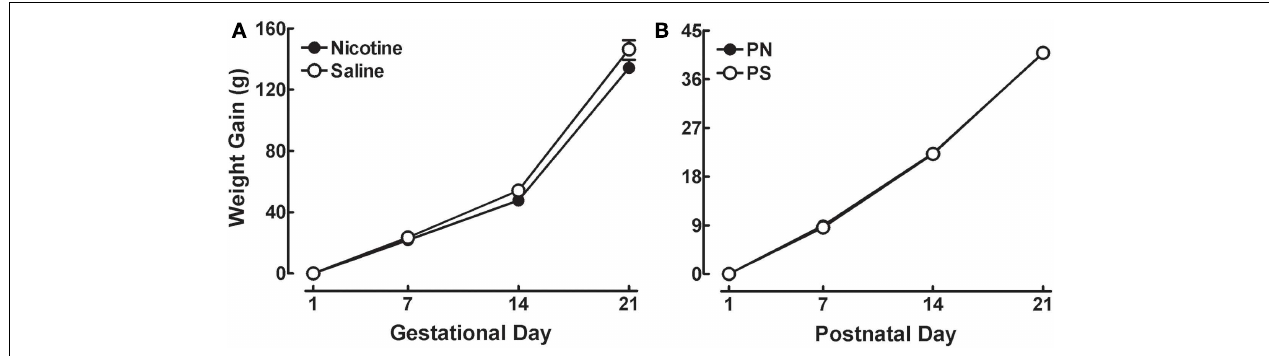
FIGURE 1 | (A) Mean ( ± SEM) weight gain data for the Saline and Nicotine dams across gestation. (B) Mean ( ± SEM) weight gain data for the PN and PS pups across PND